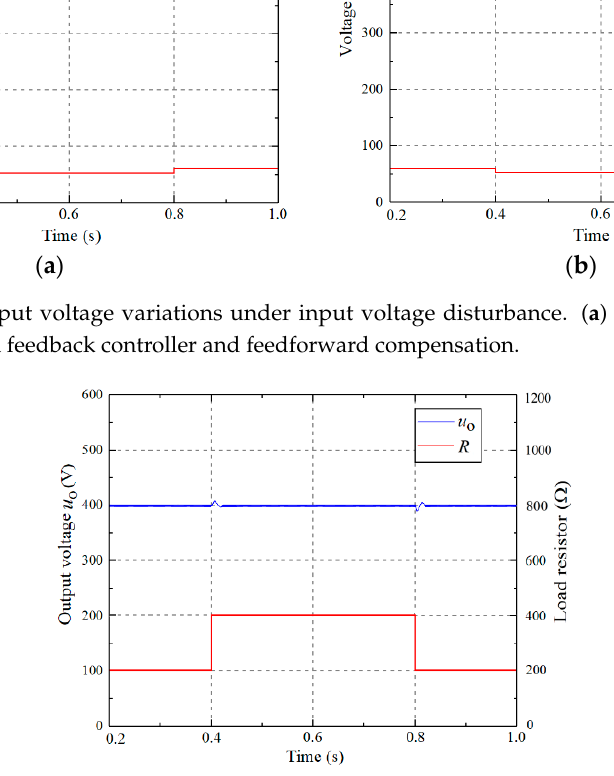
Figure 7. The output voltage during load 50% step change.